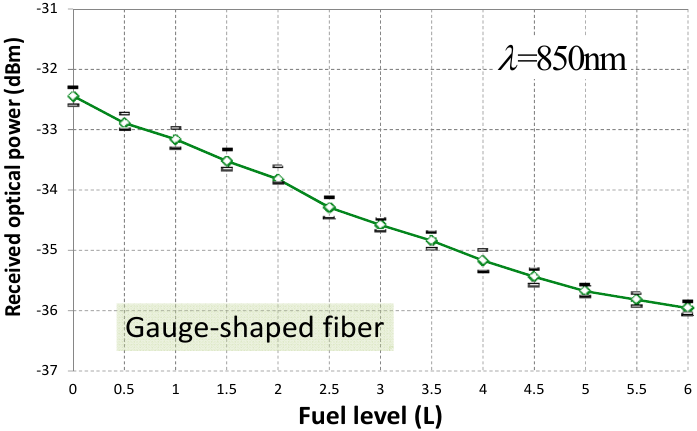
Figure 5. Optical power detected at reception versus fuel level for a gauge-shaped fiber sensing probe operating at 850 nm.